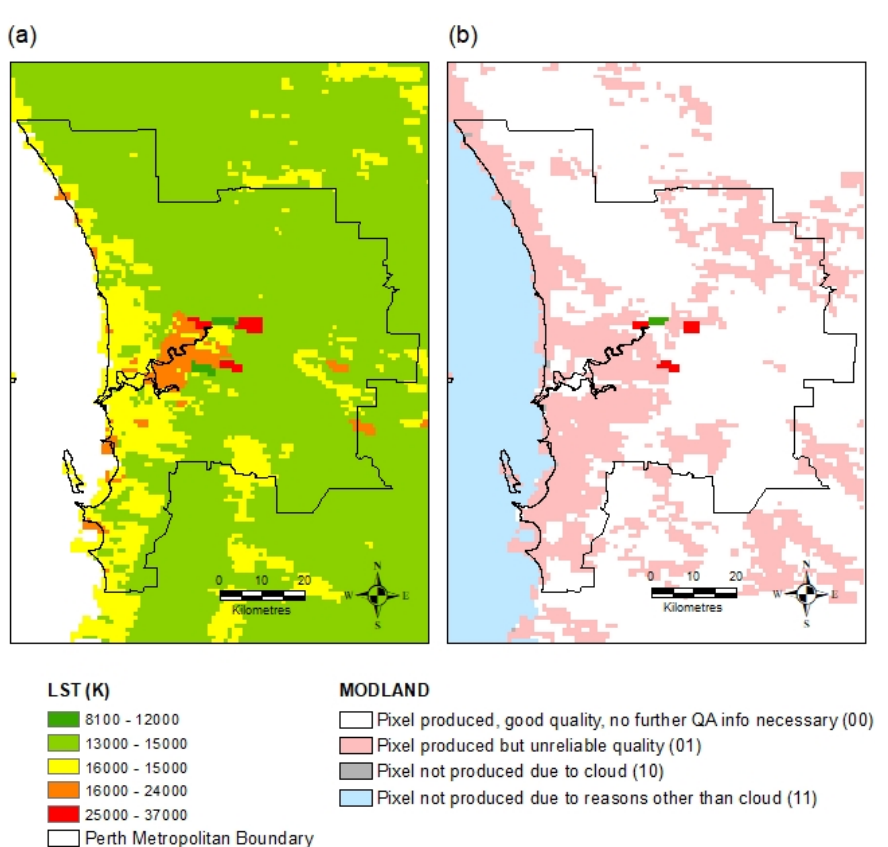
Figure 6. Perth MYD21A2 image date 2019057 : ( a ) LST with the original, unscaled K values shown and ( b ) the processed MODLAND = 00 bit flag results for the same image. The red/green pixels are the applicable high/low LST values in the image to be retained.